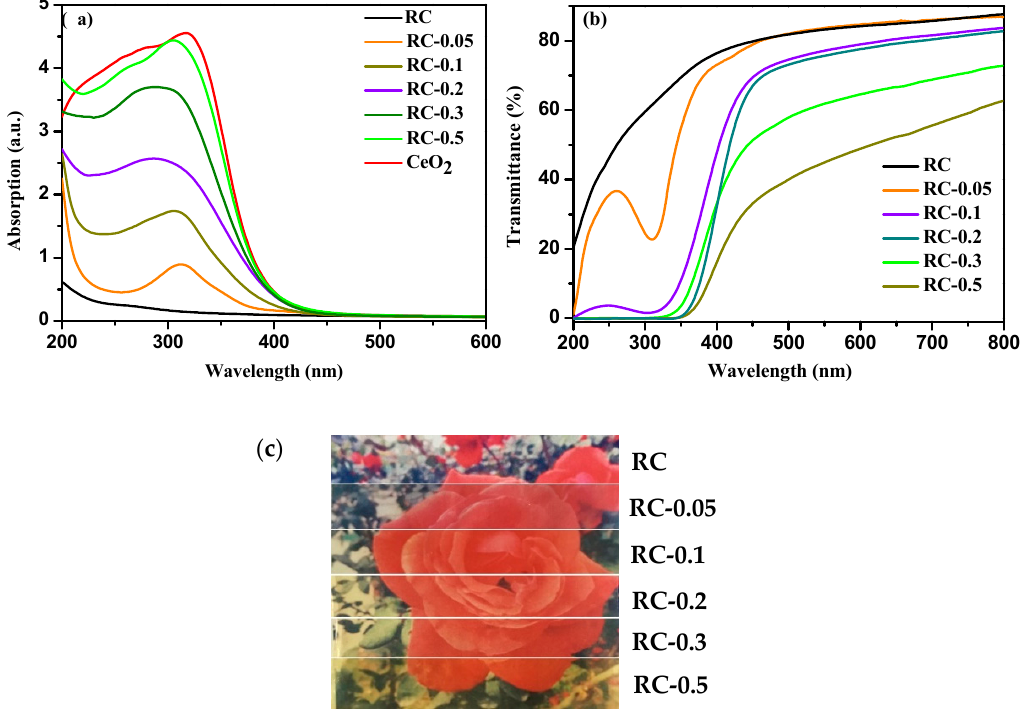
Figure 6. ( a ) Ultraviolet absorption property of CeO 2 powders, RC, and RC/CeO 2 nanocomposite films ( b ) UV–Vis transmittance of RC and RC/CeO 2 nanocomposite films; ( c ) digital pictures of RC and RC/CeO 2 nanocomposite films (tested film with a thickness of approximately 40 μ m).